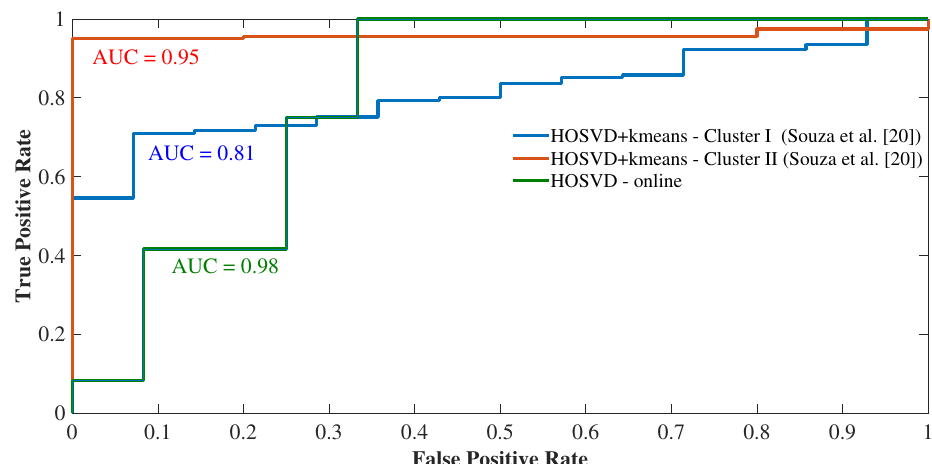
Figure 9. Detection performances of the methods HOSVD offline × HOSVD online.